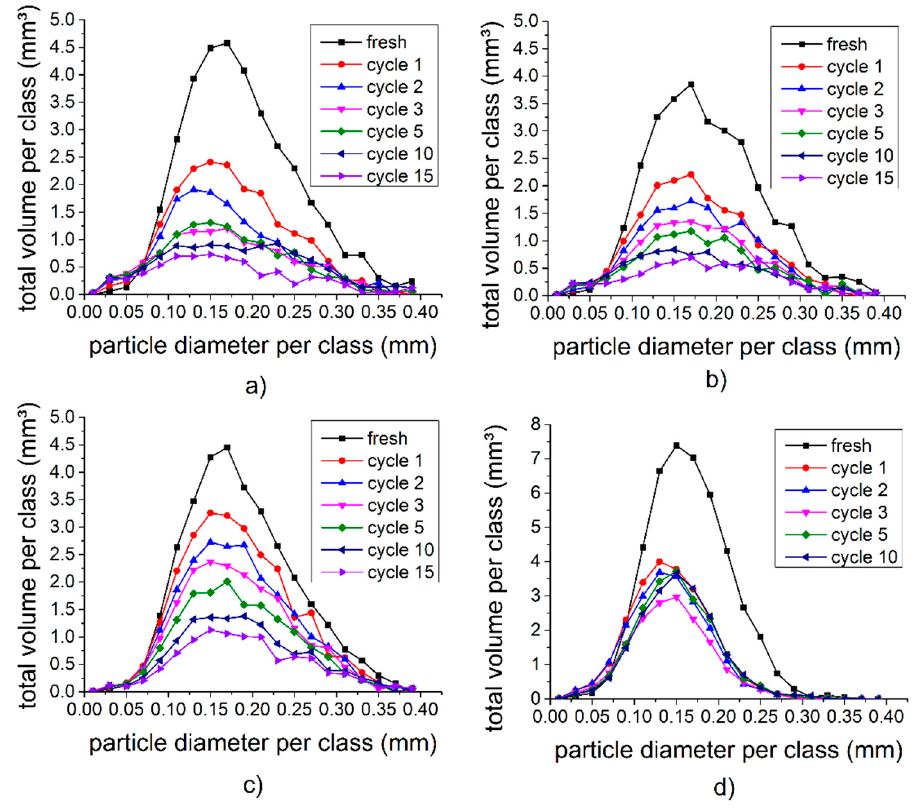
Figure 5. Particle size distributions in RAMs discharged at ( a ) 100 mA, ( b ) 200 mA, and ( c ) 400 mA and ( d ) primary cell discharged at 200 mA.